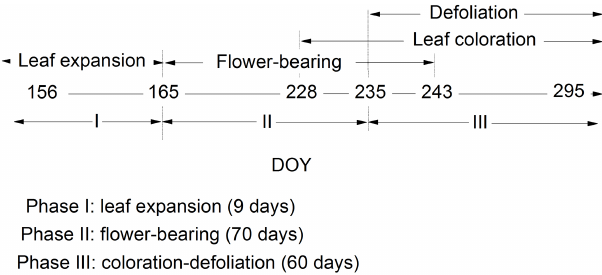
Figure 2. Phenophases of Artemisia ordosica over the measurement period. Three phases are considered, included leaf expansion (phase I), flower-bearing (phase II), and leaf coloration–defoliation (phase III)